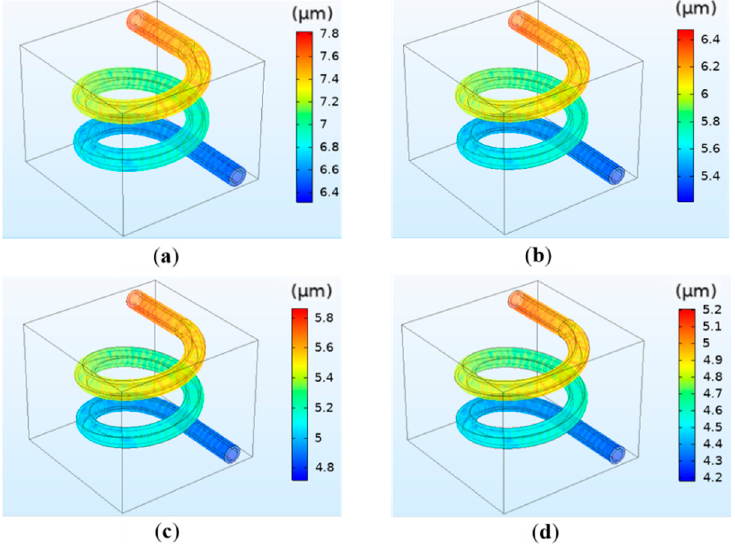
Figure 7. Simulation results of the vessel deformation when the crosslinking density is different: ( a ) 0.025 mol/L; ( b ) 0.05 mol/L; ( c ) 0.075 mol/L; ( d ) 0.1 mol/L.